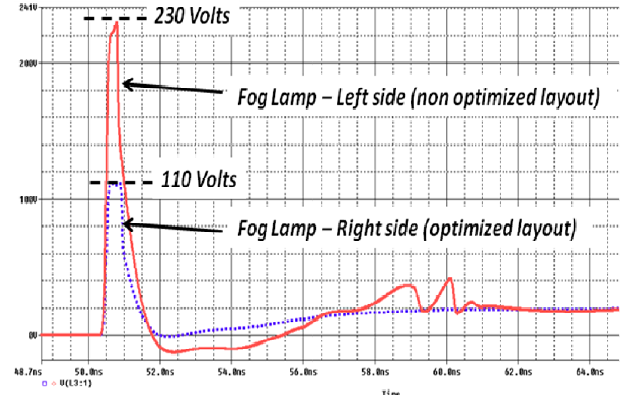
Figure 25: Voltage induced during ESD pulse on left Vs right